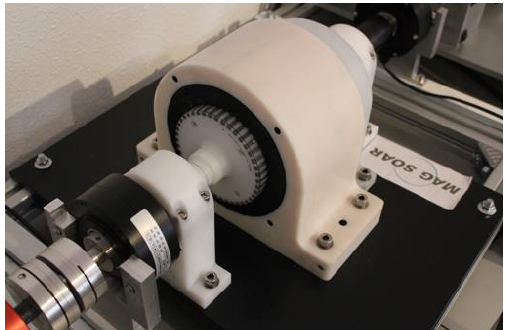
Figure 2. MAG SOAR Magdrive prototype. Max. torque 45